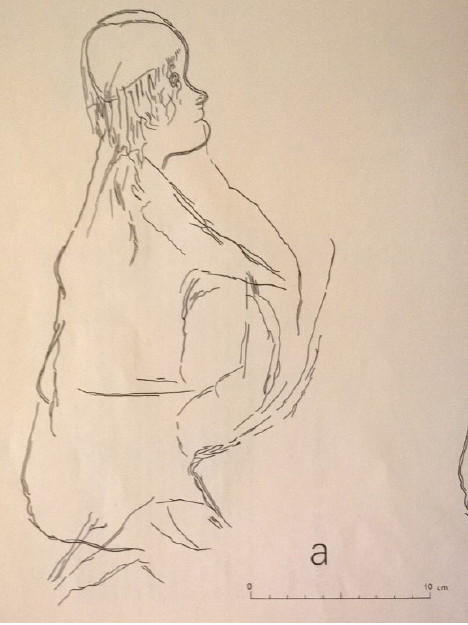
Figure 6. Group α, examples of Hand α1: Obs. 3 (from Pales, 1976).